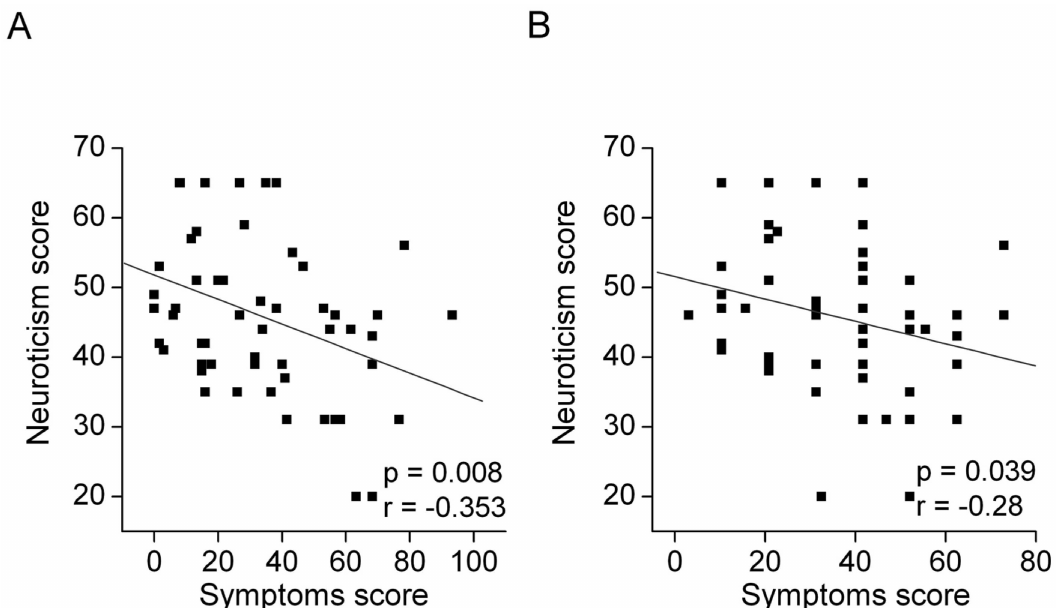
Fig 2. Correlations between the subjective dry eye symptoms and the neuroticism score in the scatterplots. A) DEQS and Neuroticism. Individualswith a lower neuroticism score (more nervous) exhibiteda higherDEQS score (more symptoms). There is a significantcorrelation between the neuroticismscore and the DEQS score (r = -0.353, p = 0.008). r; Spearman’scorrelation coefficient. The gray line indicatesthe regression line. B) OSDI and Neuroticism. Individuals with a lower neuroticism score (more nervous)exhibiteda higherOSDI score (more symptoms). There is a significantcorrelation betweenthe neuroticism score and the OSDI score (r = -0.28, p = 0.039). r; Spearman’s correlationcoefficient. The gray line indicates the